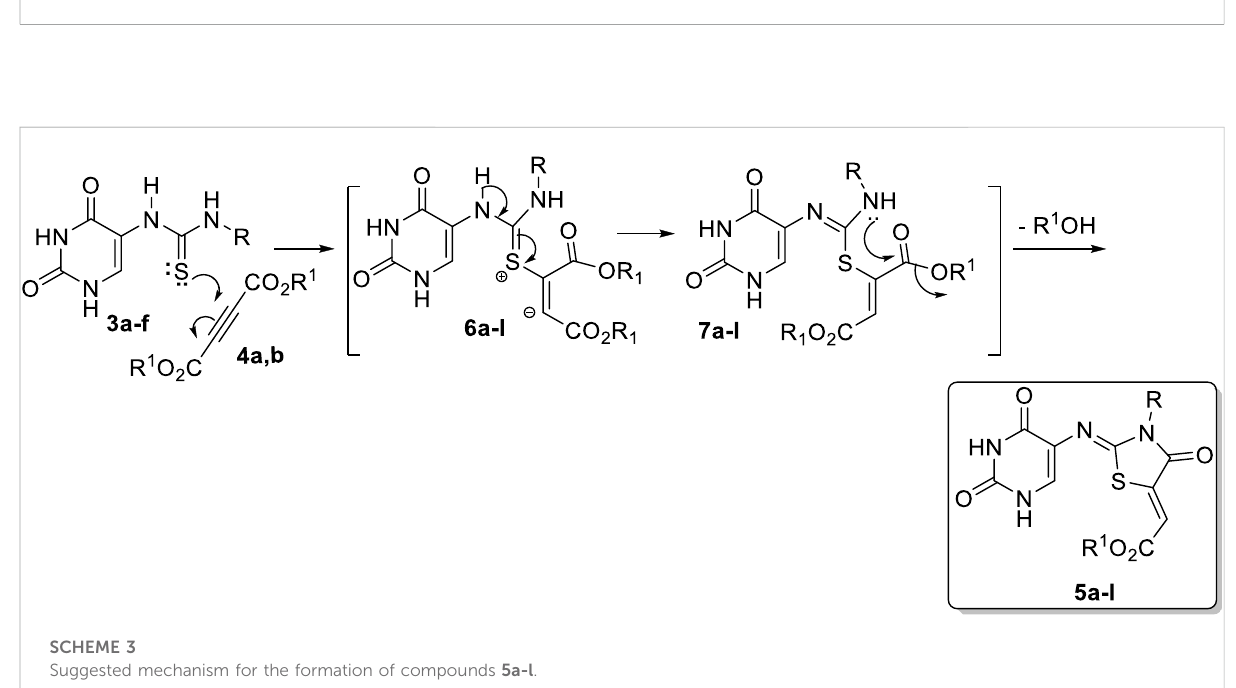
FIGURE 6 Resonance stabilized compounds 5a-l